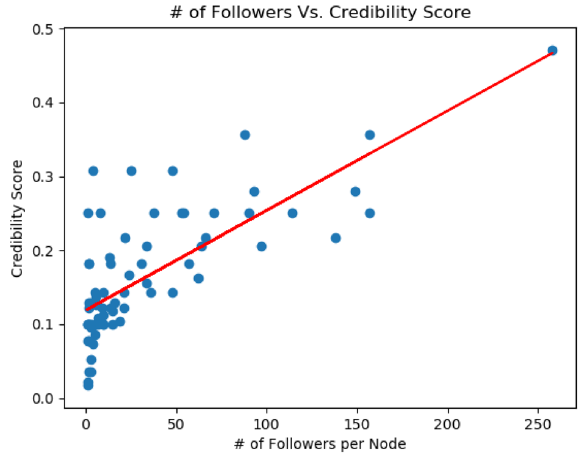
Figure 2. Fitted regression curve to follower counts against credibility score.